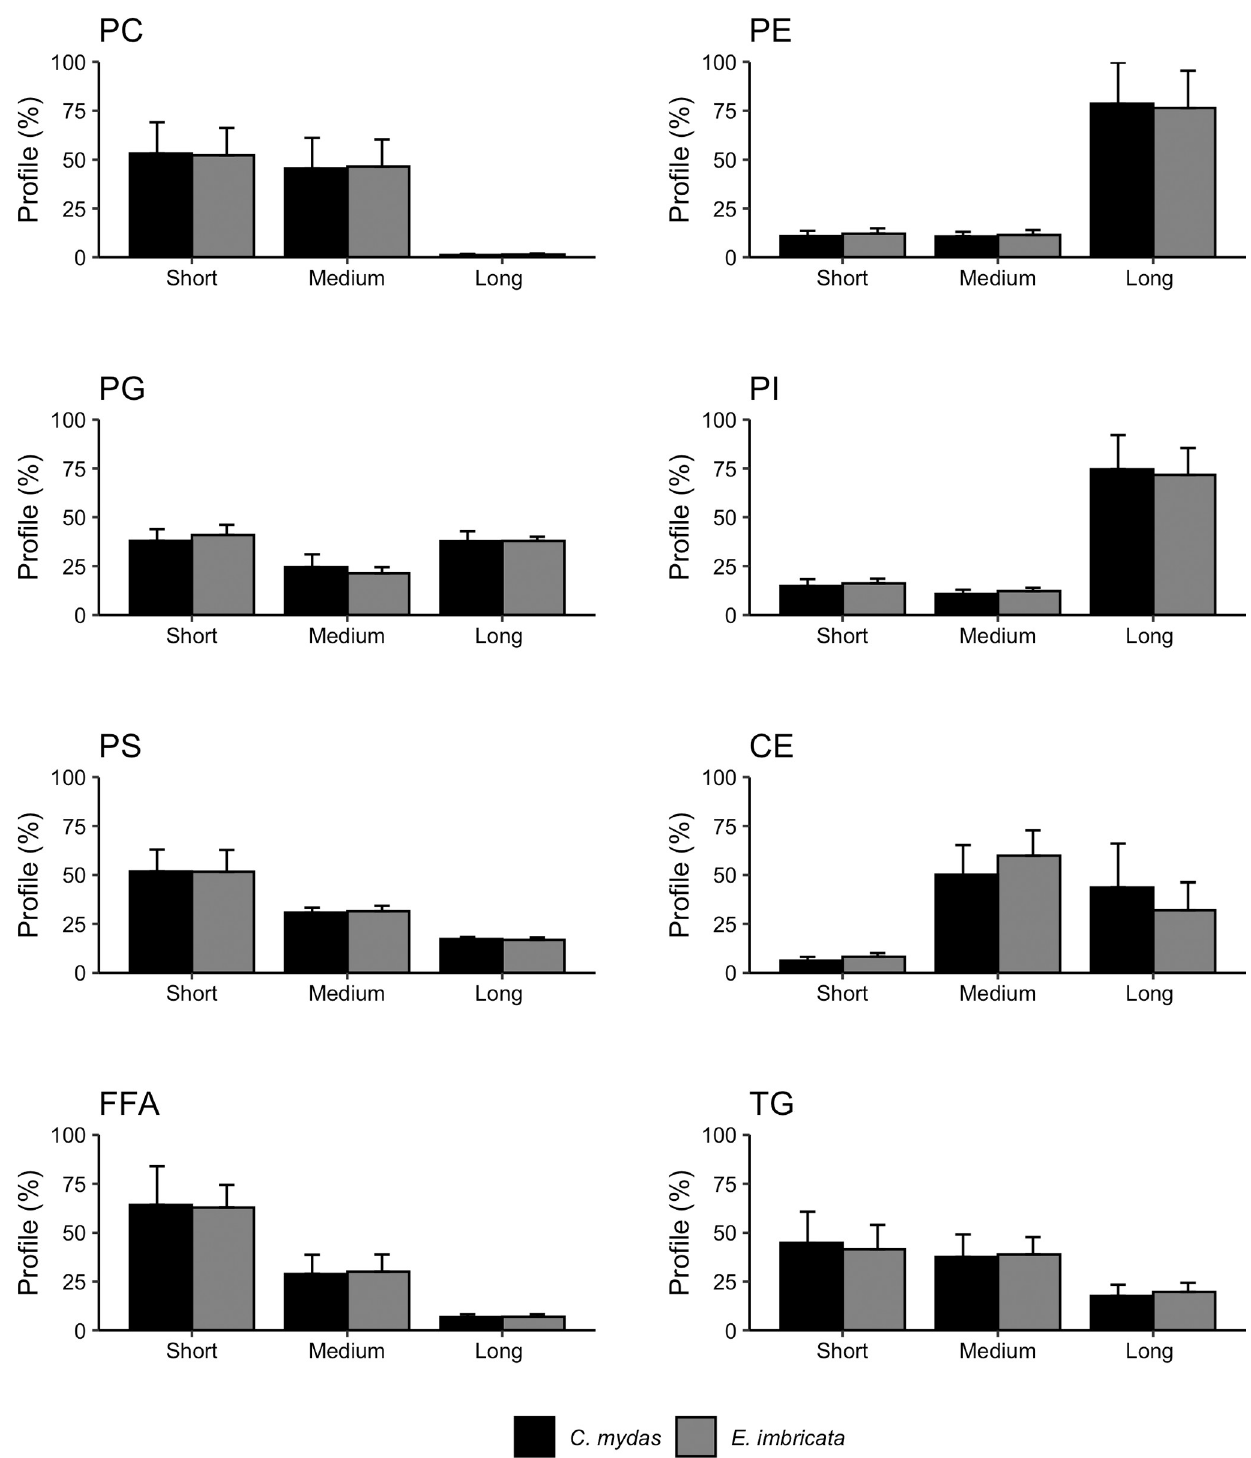
Fig 1. Percent lipid class profile from sea turtles divided by chain length and species. The x-axis represents chain length and was divided based on each profile separately. Bars and error bars represent mean ± standard deviation (%). We did not include sphingomyelin, acyl-carnitine, or ceramide classes due to structure. PC = phosphatidylserine (short = 30–36 carbons, medium = 38–42 carbons, long = 44–48 carbons); PE = phosphatidylethanolamine (short = 12–22 carbons, medium = 24–34 carbons, long = 36–42 carbons); PG = phosphatidylglycerol (short = 12–22 carbons, medium = 24–34 carbons, long = 36–44 carbons); PI = phosphatidylinositol (short = 12–22 carbons, medium = 24–34 carbons, long = 36–44 carbons); PS = phosphatidylserine